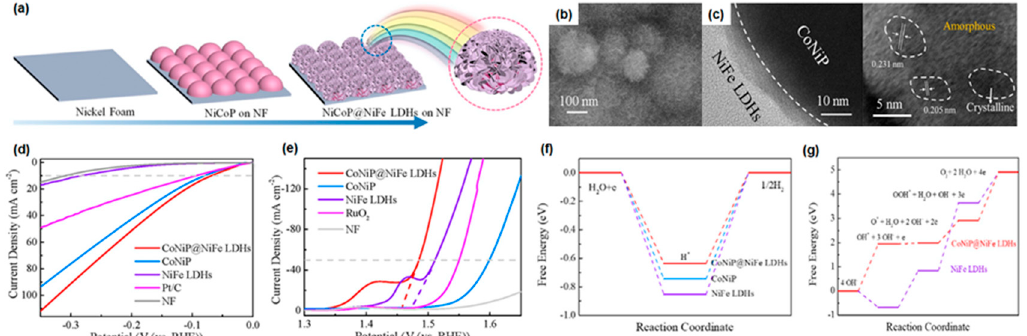
Figure 2. ( a ) The illustration for the preparation of CoNiP@NiFe LDH heterostructure directly on NF substrates through a two-step electrodeposition method. ( b ) Field-emission scanning electron microscope (FE-SEM) image of CoNiP@NiFe LDHs. ( c ) High-resolution transmission electron microscope (HR-TEM) image of CoNiP@NiFe LDHs. Polarization curves with 85% iR correction for ( d ) HER and ( e ) OER. ( f ) Gibbs free energy diagram vs. reaction coordinate of the HER with the c-CoNiP (001), c-NiFe LDHs (001), and c-CoNiP@NiFe LDHs. ( g ) Gibbs free energy diagram vs. reaction coordinate of the OER with the NiFe LDHs and c-CoNiP@NiFe LDHs. Reprinted (adapted) from [125], copyright (2023) Elsevier Ltd.